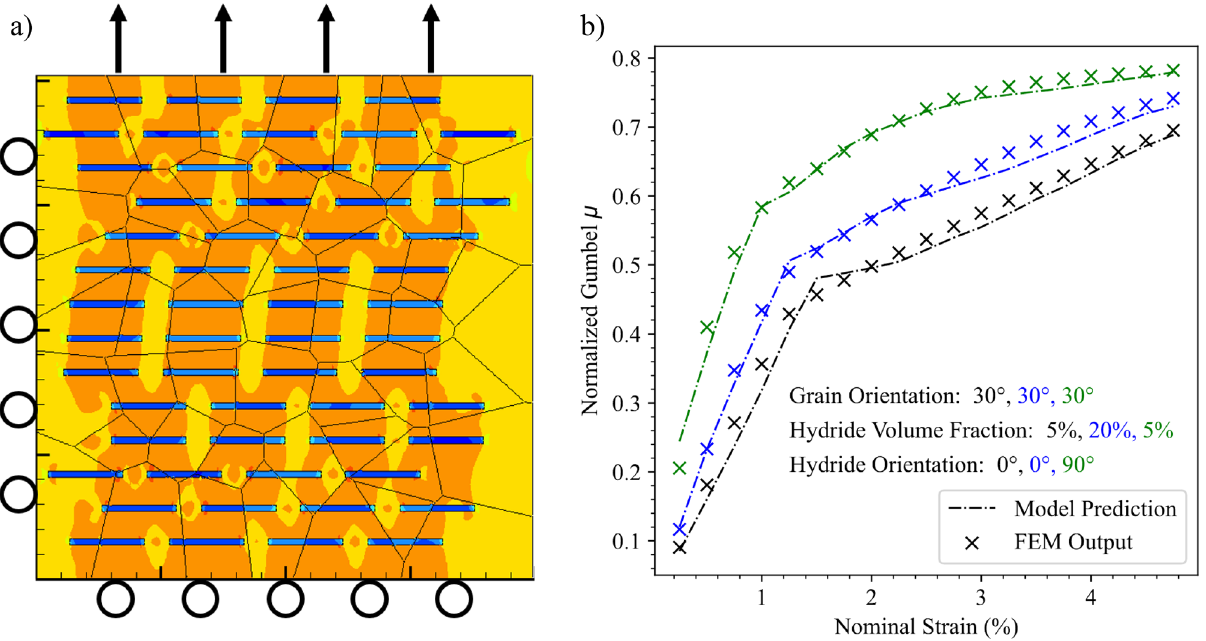
Figure 2. ( a ) The finite-element representation of a multiphase hydrided zirconium alloy representative volume element. The arrows correspond to the applied tensile displacements. ( b ) Model verification as a function of strain response. The coloring indicates a subset of material parameters as referenced in the center legend. Grain orientation, hydride volume fraction, and hydride orientation were varied and the model prediction at various strain levels was compared to FEM output.